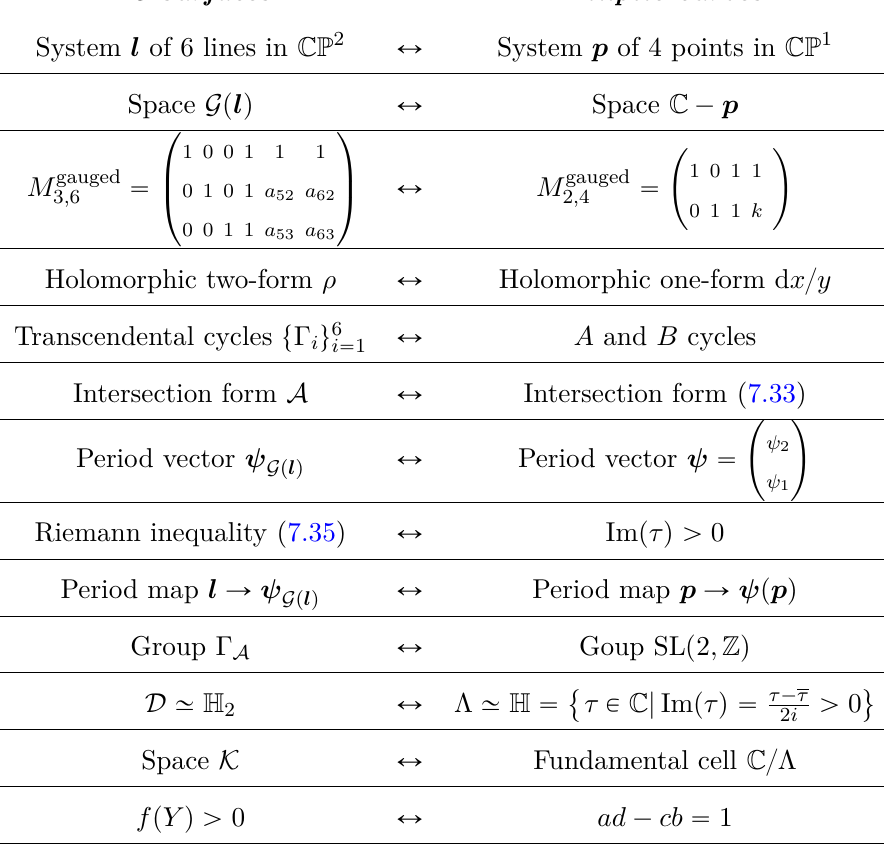
Table 3 . Similarities between the modular interpretations of K3-surfaces and elliptic